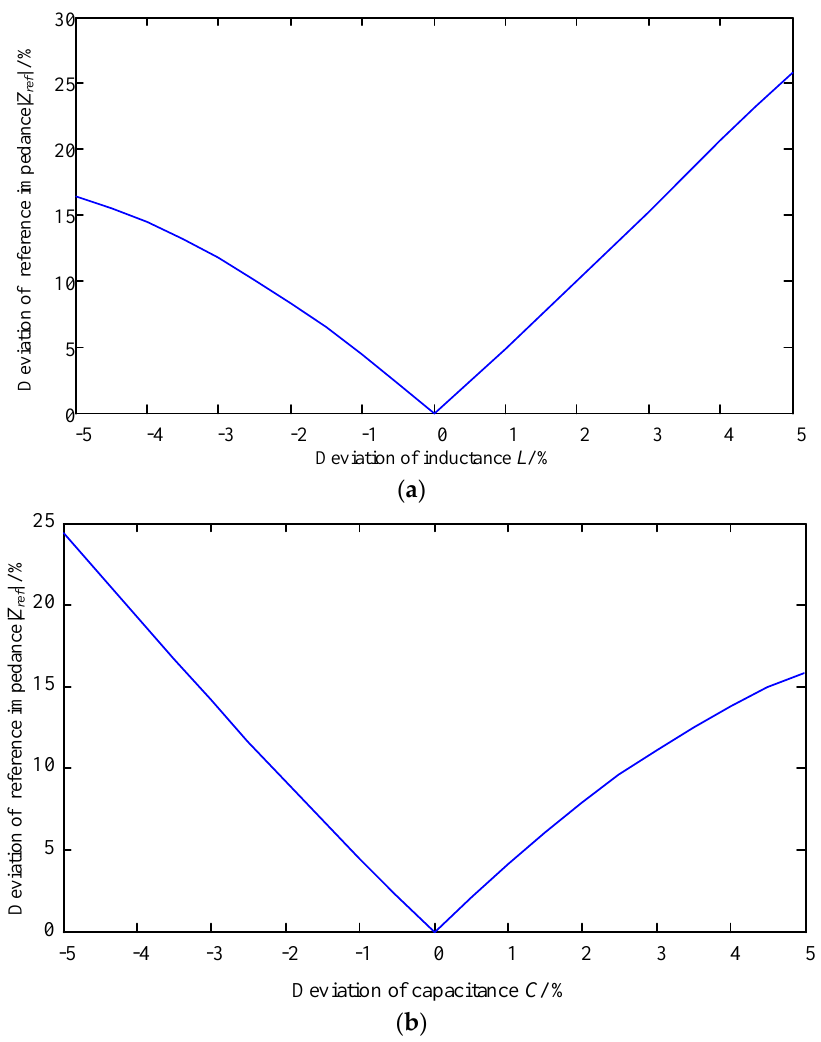
Figure 3. The effect of line parameters variation on the reference impedance. ( a ) Effect of inductance variation on VSWR; ( b ) Effect of capacitance variation on VSWR.